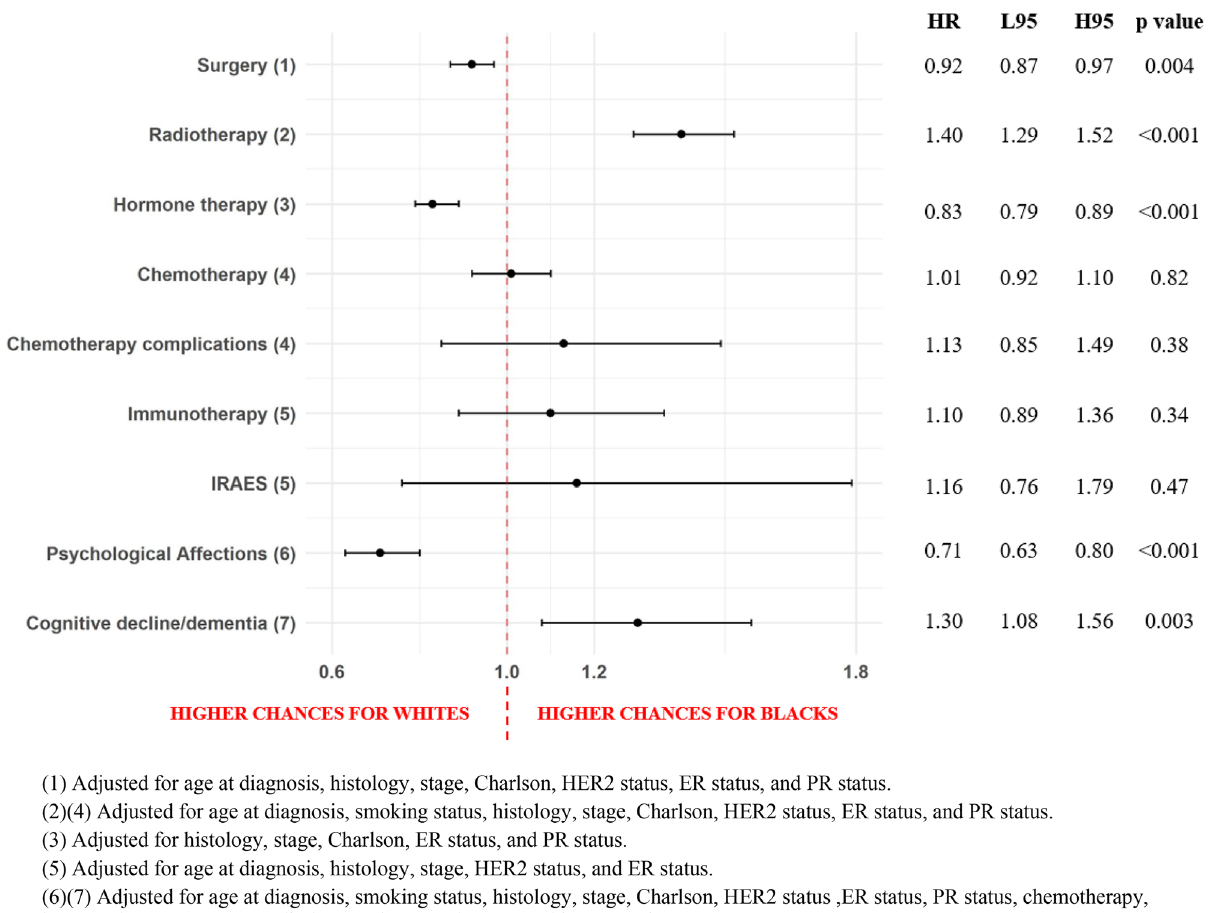
Figure 2. Forest plot detailing association between race and treatment patterns or treatment adverse events for Breast Cancer University Hospitals (UH) population (2005–2022). Results are presented in hazard ratios (HR) for Blacks, lower 95% confidence intervals (L95), higher 95% confidence intervals (H95), and p